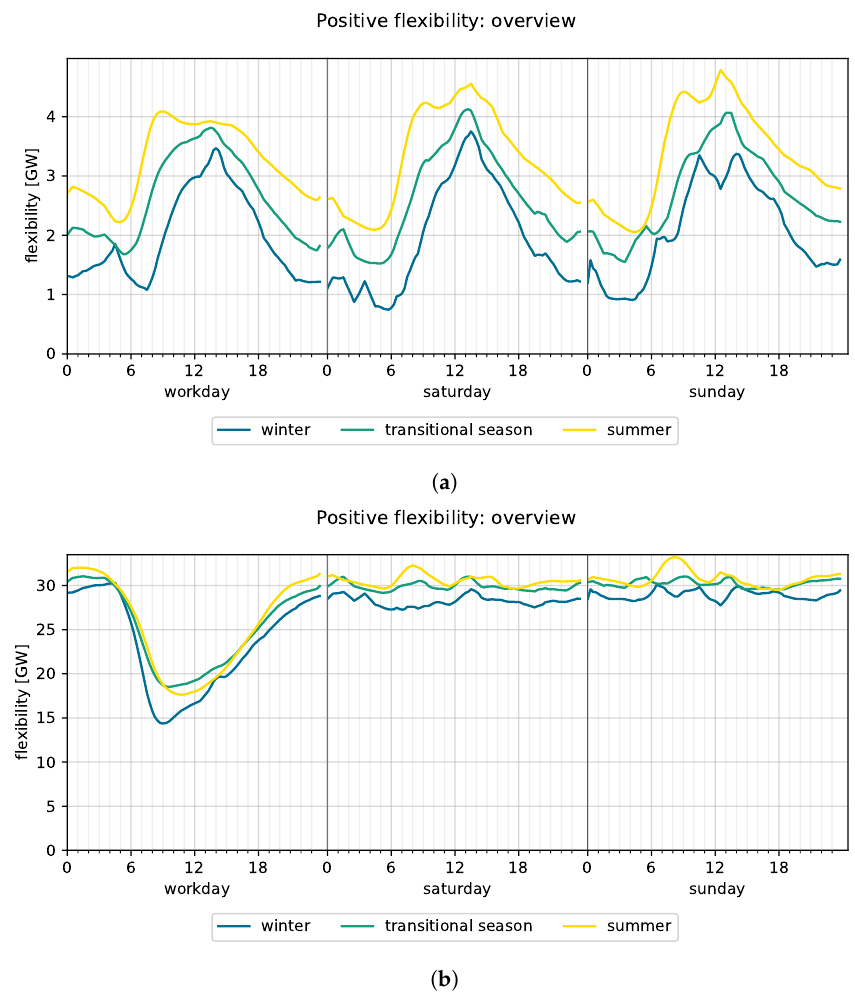
Figure 8. Comparison of the immediately available positive flexibility on the basis of the weighted scenario for the years ( a ) 2025 and ( b )